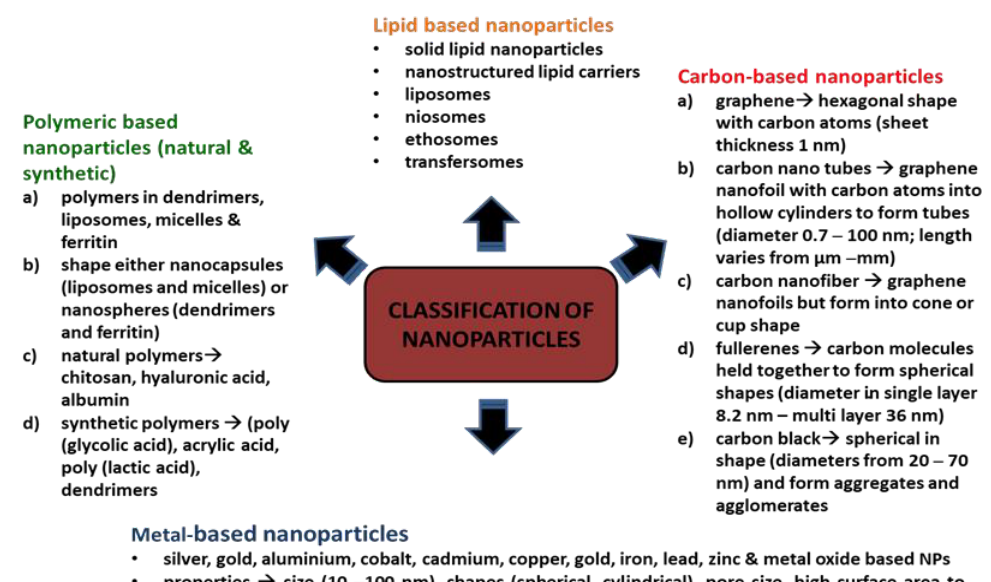
Figure 1. Classifications of nanoparticles.